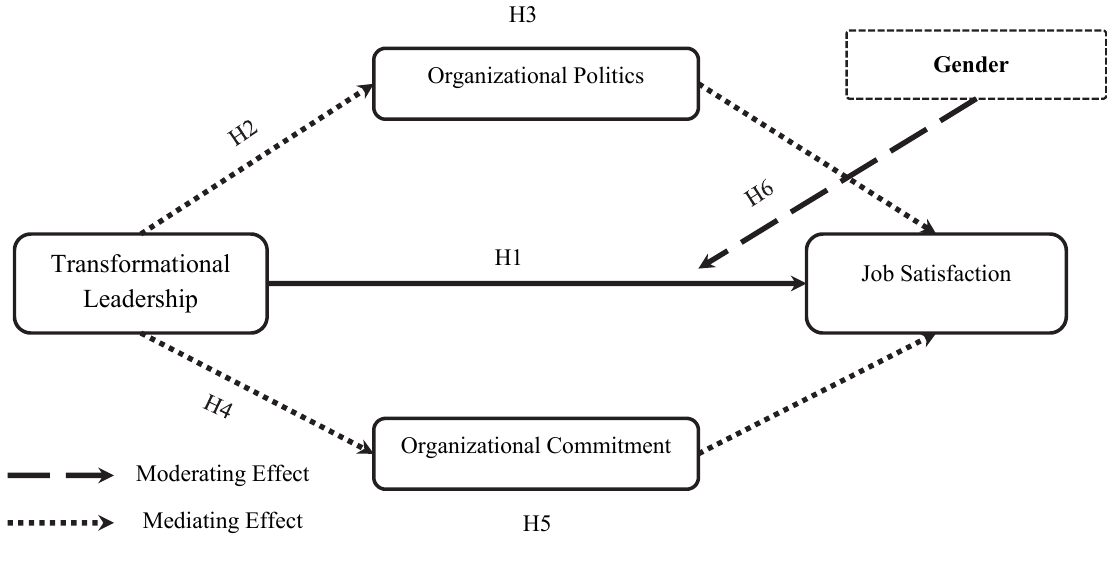
Fig. 1. Conceptual research